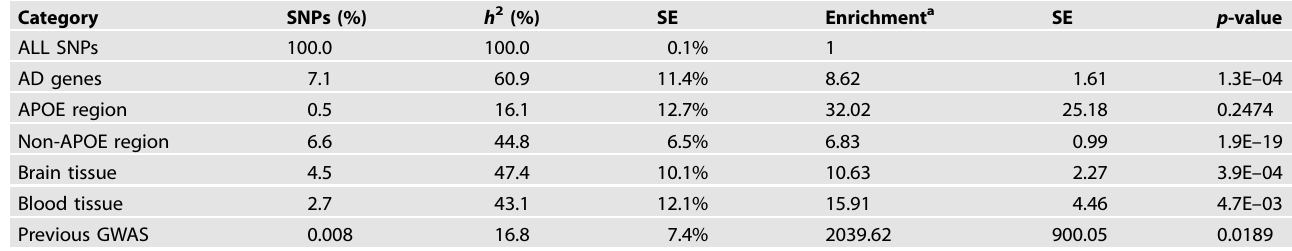
Table 4. Partitioned of the SNP-based heritability of